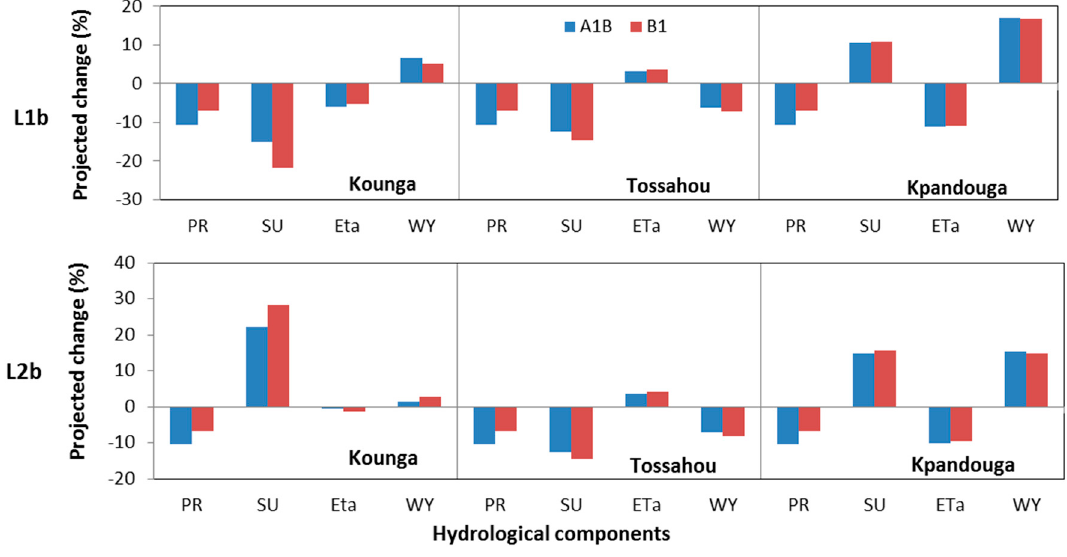
Figure 6. Changes in the annual water balance components under climate and land use change during the projected period of 2030–2049 compared to climate change scenarios alone. L1b and L2b are land use change scenarios of 25% and 75% lowland conversion with no fertilizer application, respectively. A1B and B1 are climate change scenarios; ETa is actual evapotranspiration; PR is precipitation; SU is surface runoff; and WY is total water yield.